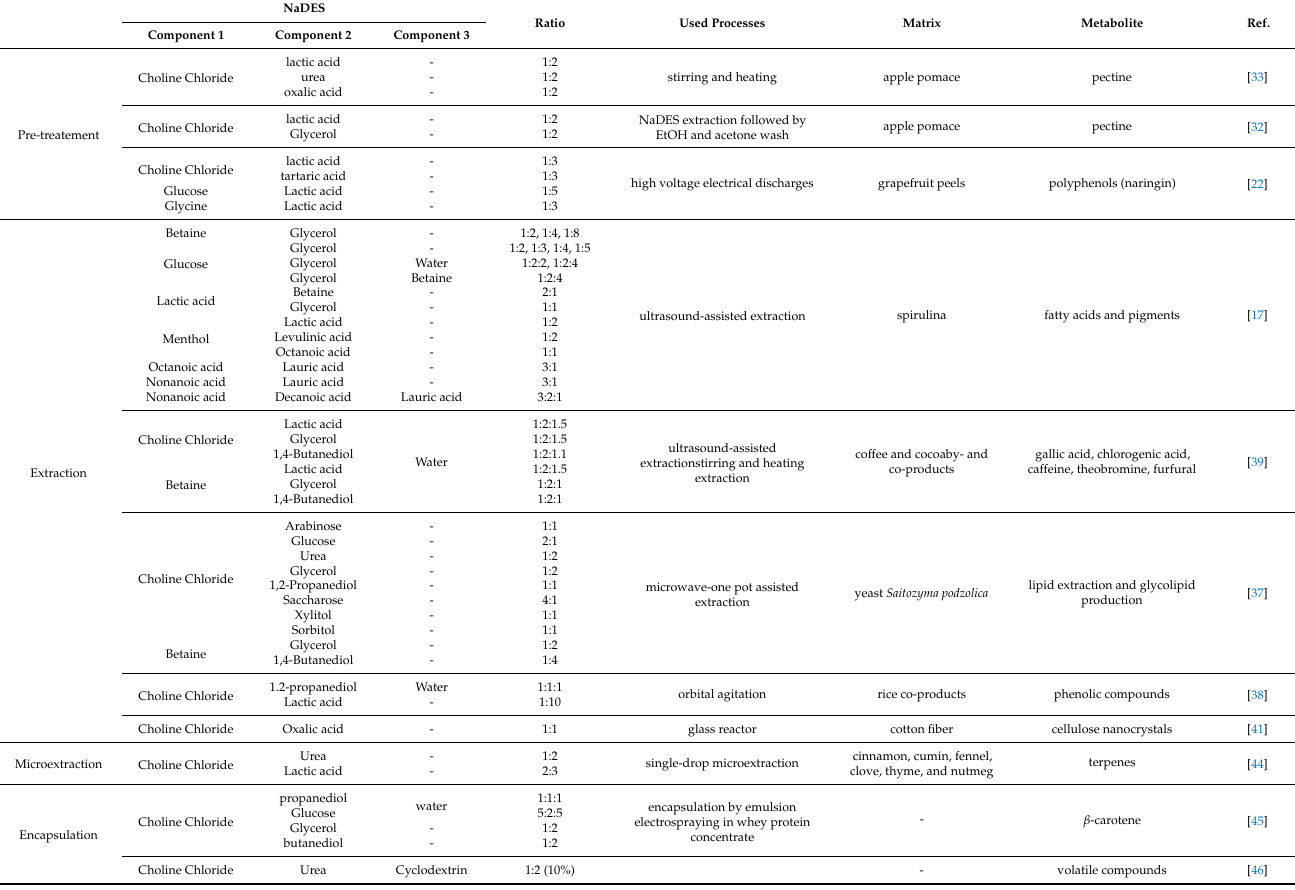
Table 1. NaDES used in biomass pre-treatment, extraction and